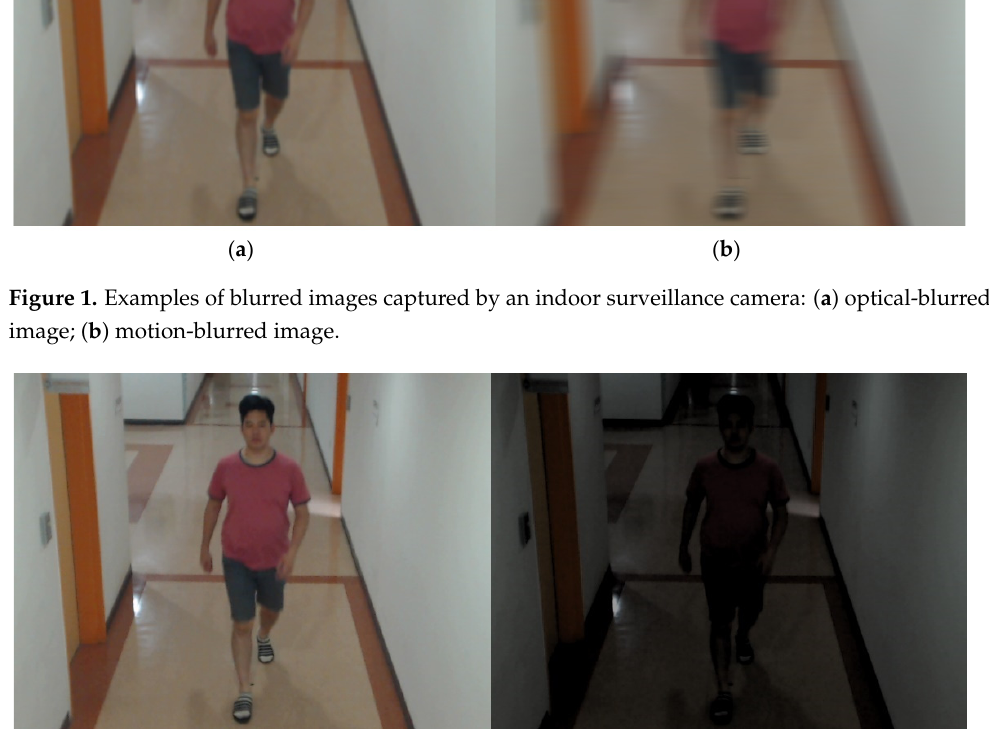
Figure 1. Examples of blurred images captured by an indoor surveillance camera: ( a ) optical-blurred image; ( b ) motion-blurred image.